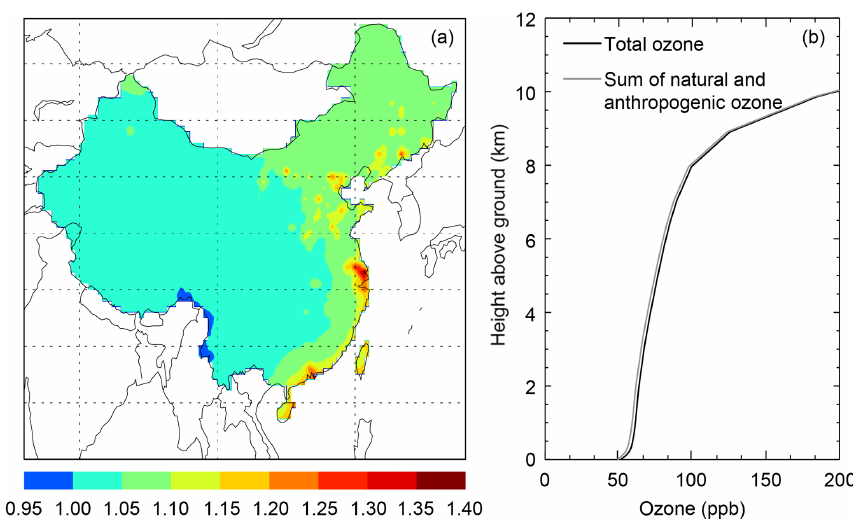
Figure 2. (a) Spatial distribution of the ratio of total surface ozone in CTL to the pre-linear-weighting-adjustment sum of natural ozone, domestic anthropogenic ozone, and foreign anthropogenic ozone. (b) Vertical profile of China average total ozone from CTL and the profile of the pre-linear-weighting-adjustment sum of natural ozone, domestic anthropogenic ozone, and foreign anthropogenic ozone.